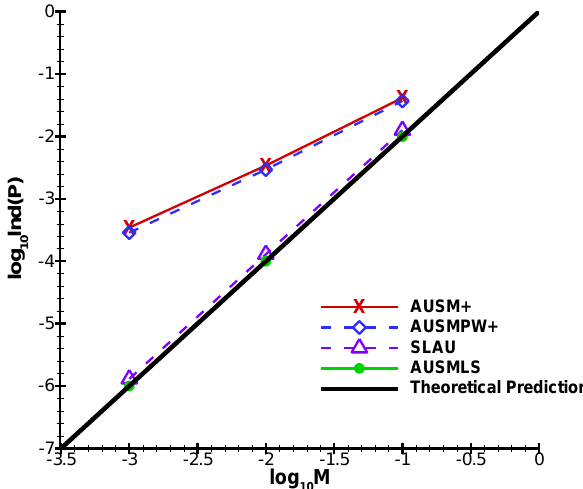
Figure 3. The computational grid of NACA0012 (120 × 50).